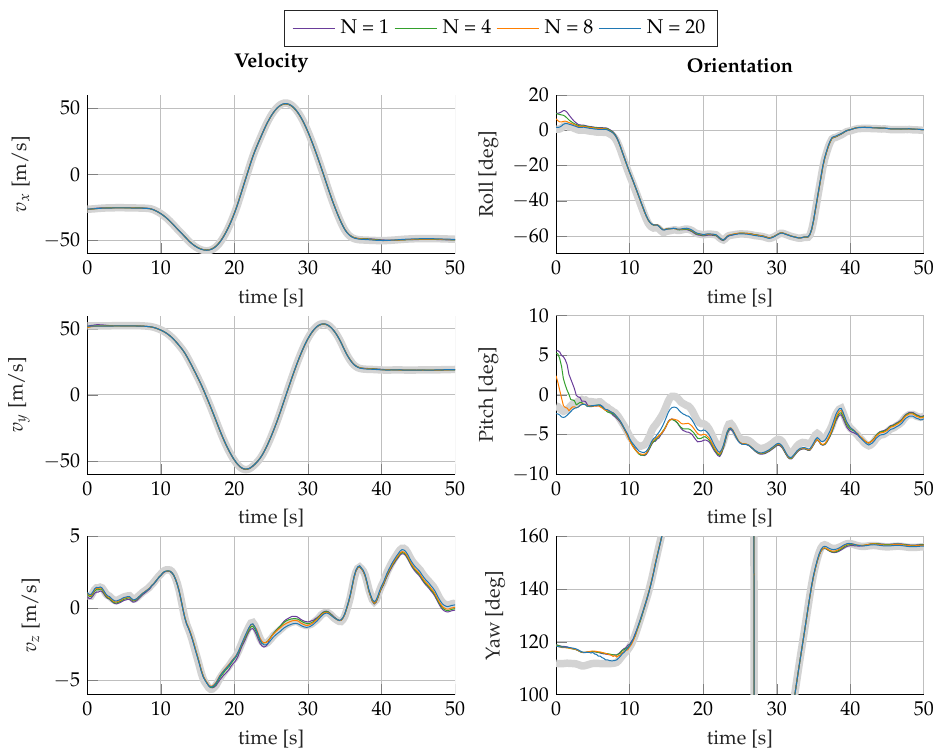
Figure 6. Estimated state trajectories for the first 50 s of velocity and orientation for increasing horizons N , compared to the reference trajectory ( ).